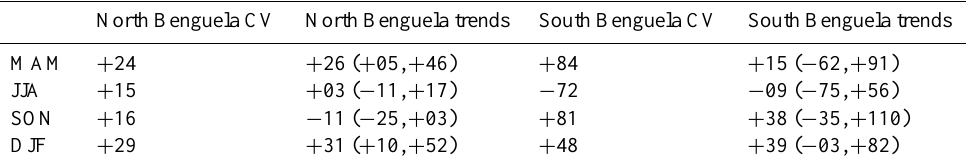
Figure 4. Long-term mean of sea level pressure (a) , wind (b, c) , and wind stress curl (d, e) of NCEP/NCAR reanalysis in the period 1948–2011. Table 2. Coefficients of variation (CV, ratios between interannual SD and long-term mean, in %) and trends in upwelling intensity over the period 1950–2010 as simulated in the STORM simulation. The magnitude of the trends is expressed as total linear changes over the period 1950–2010 relative to the long-term mean. The figures in parenthesis bracket the nominal 95% uncertainty range in the trend estimation, assuming uncorrelated and Gaussian-distributed trend